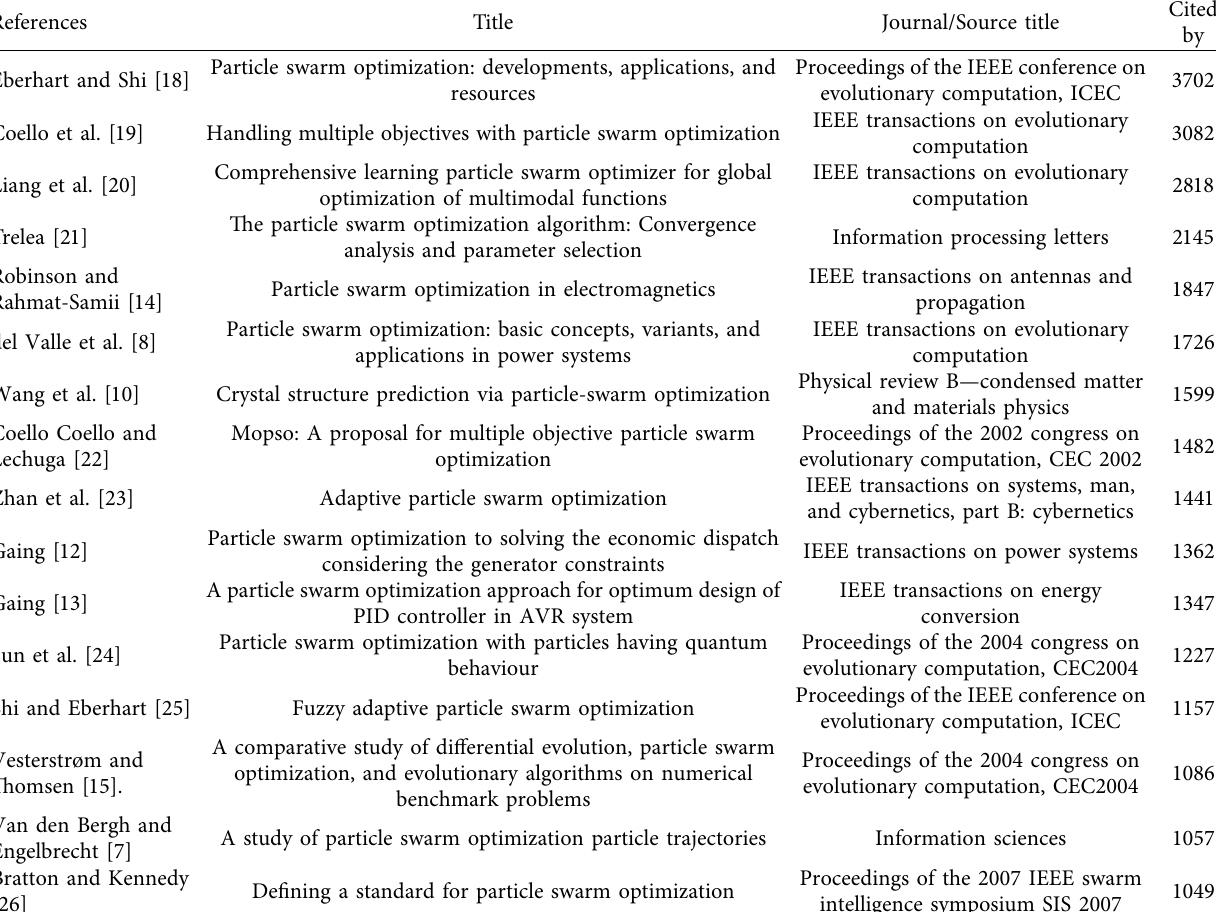
Table 1: Top cited publications on PSOA